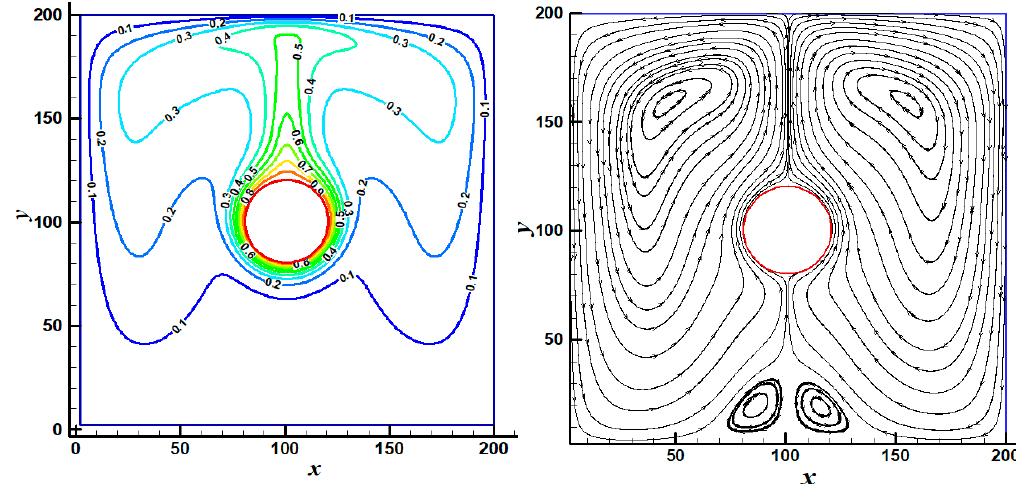
Figure 2. Set-up, consists of an annular space between an outer square enclosure (cold) and an inner circular cylinder (hot), considered for validating the present numerical method.